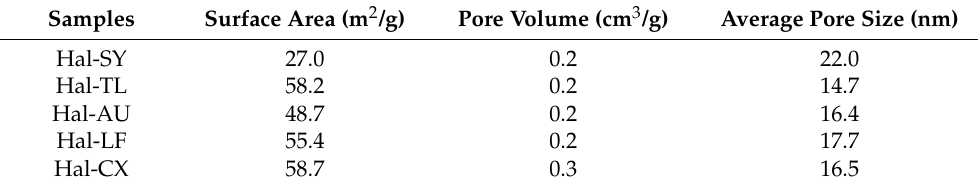
Figure 4. ( a ) N 2 adsorption-desorption isotherms and ( b ) pore size distributions of the Hal samples. Table 4. BET-specific surface area, pore volume and BJH adsorption average pore size of Hal samples. Samples Surface Area (m 2